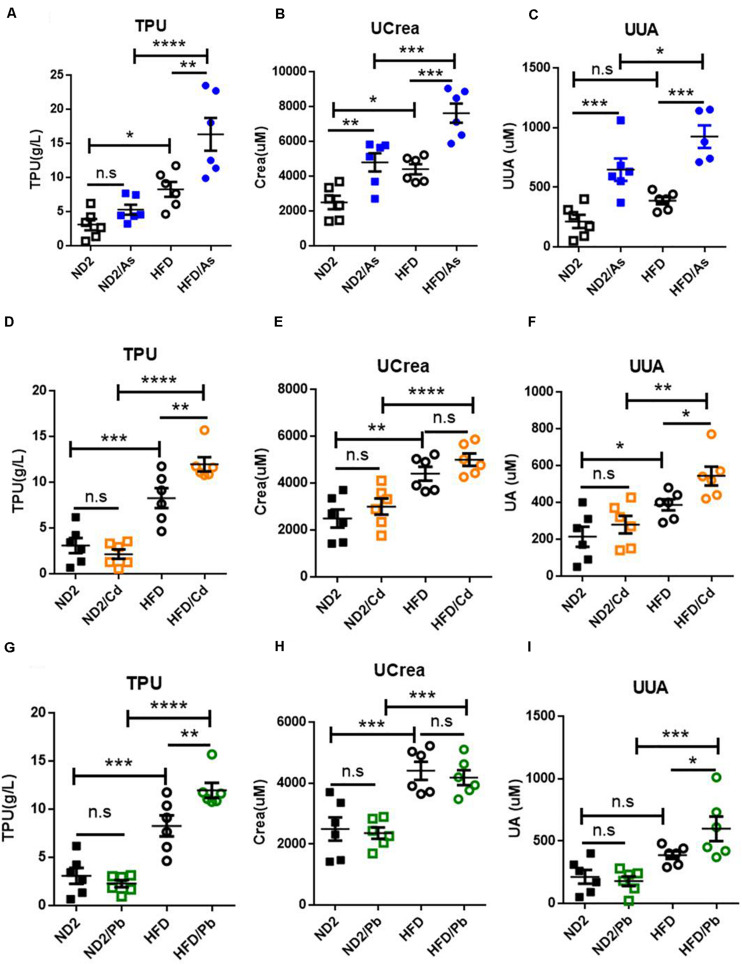
Diet effects on kidney function damage upon heavy metal exposure. (A–I) ND- and HFD-fed mice were exposed to 100 ppm As, Cd, or Pd for 10 weeks (n = 6 for each group). Urine was collected and analyzed for total protein, uric acid, and creatinine contents on the day of sampling. Data were expressed as mean ± SEM. Statistics according to two-way ANOVAs and Bonferroni post hoc tests. n.s. not significant; *P < 0.05; **P < 0.01; ***P < 0.001; ***P < 0.0001. TPU, urinary total protein; UUA, urinary uric acid; Ucrea, urinary creatinine.